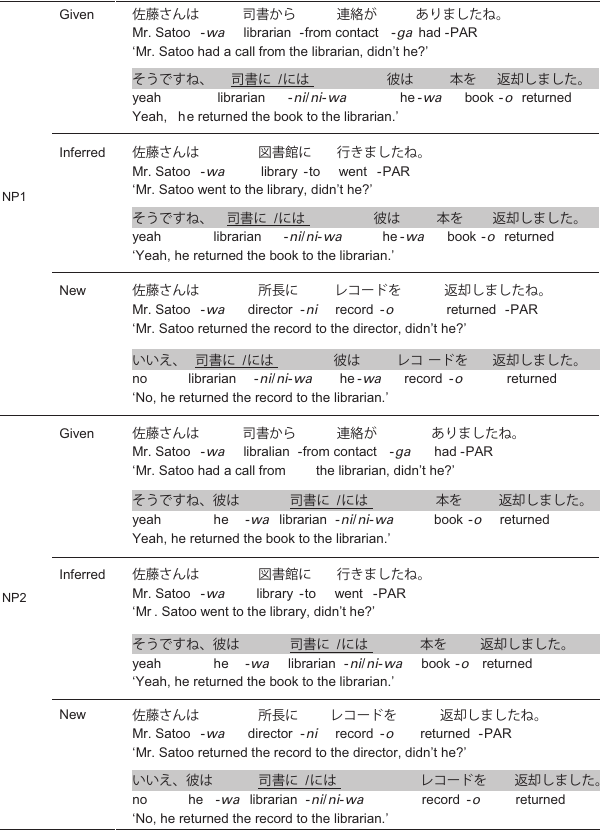
Table 1 | Examples of critical conditions in Experiment 1 for the factors position (NP1, NP2), marker ( ni , ni-wa ), and context (Given, Inferred, Contrastive